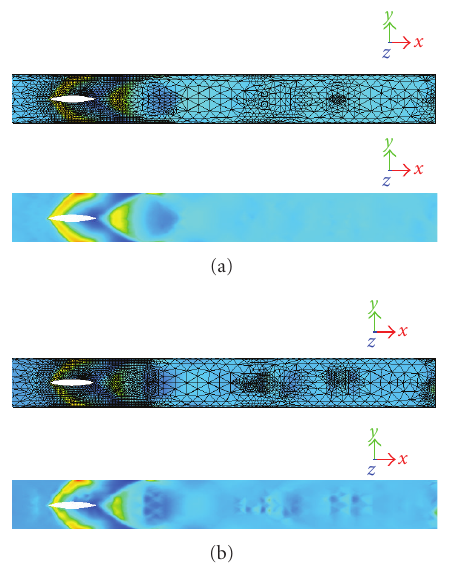
Figure 12: Grids and density solution downstream of the blade— (a) and (b), second step with and without projection, respectively.